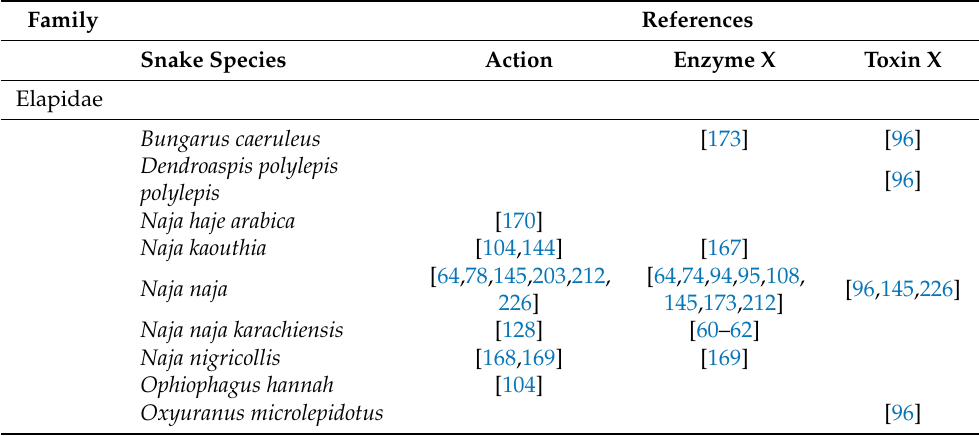
Figure 2. Modern literature evidence on snake species-specific inhibition of venom and its components. Table 5. Snake species-wise literature references indicating pharmacological action, enzyme inhibition and toxin